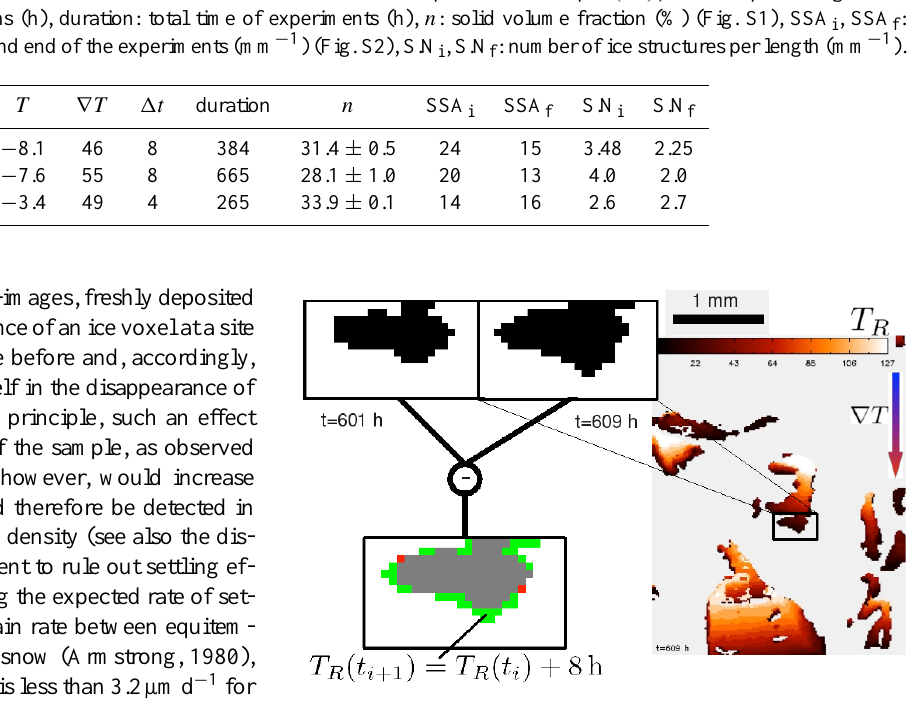
Fig. 1. Illustration of the calculation of residence time of the ice voxels. The zoomed boxes show the same ice structure (black) at two subsequent time-steps. Subtracting the images yields the subli- mated (red) and freshly deposited (green) ice mass. New voxels are assigned an “age” of 1t = 8h; the time label for unmodified voxels (gray) is incremented by 1t . The color-coded image on the right shows a steady-state distribution of residence times T R . Note that the bottom of that image corresponds to the warm side, as indicated by the temperature gradient ∇ T